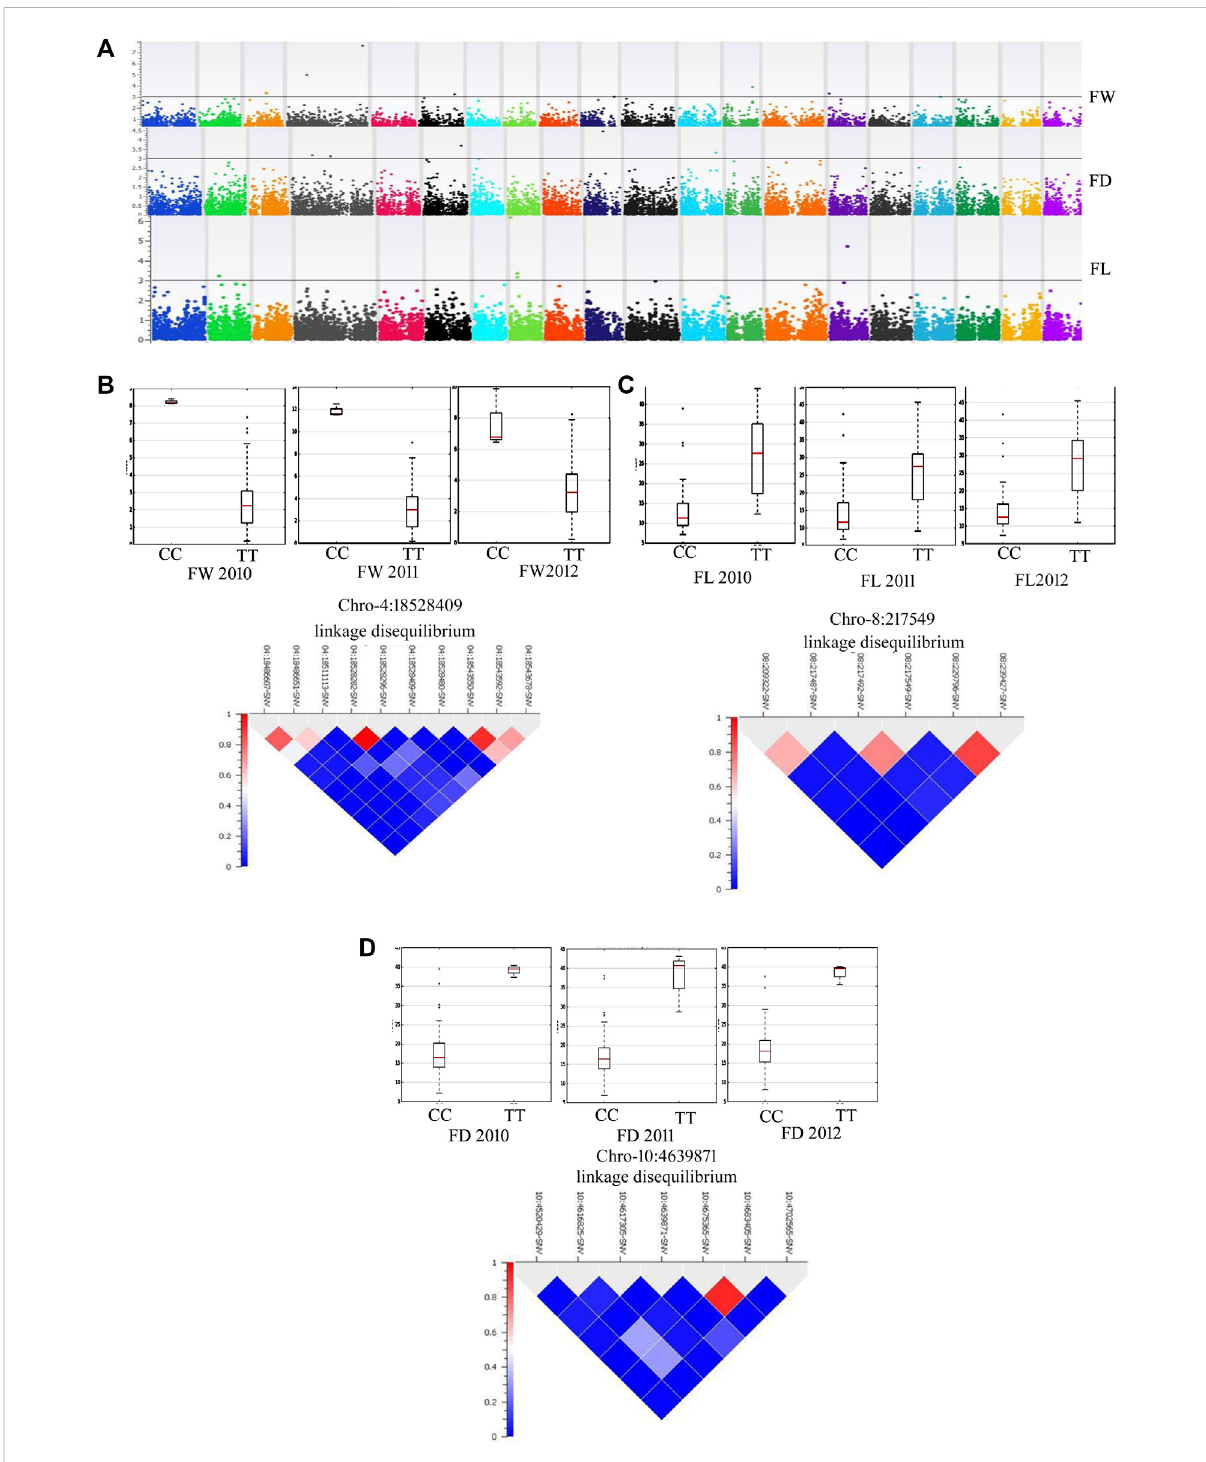
FIGURE 5 (A) ManhattanplotsshowingGWASresultsforvariousfruittraits[FW:fruitweight(lb),FL:fruitlength(cm)andFD:fruitdiameter(cm)]acrossthe years 2010, 2011 and 2012. (B) Allelic effects of SNP 18528409 on chromosome 4 for FW. (C) Allelic effects of SNP 217549 on chromosome 8 for FL. (D) Allelic effect of SNP 4639871 on chromosome 10 for